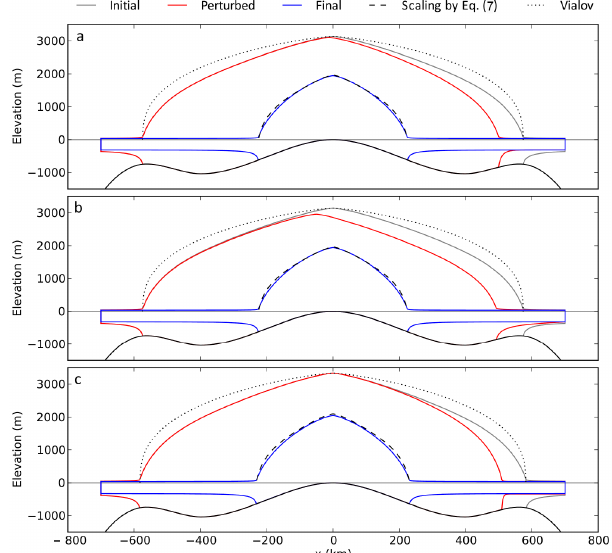
Figure A1. Ice-sheet profiles at three stages of simulation for a cen- tral bed elevation of b c = 0m with applied (a) oceanic (same as Fig. 3a) and (b) atmospheric perturbation. Panel (c) shows a set of SSA only simulations using an oceanic perturbation.